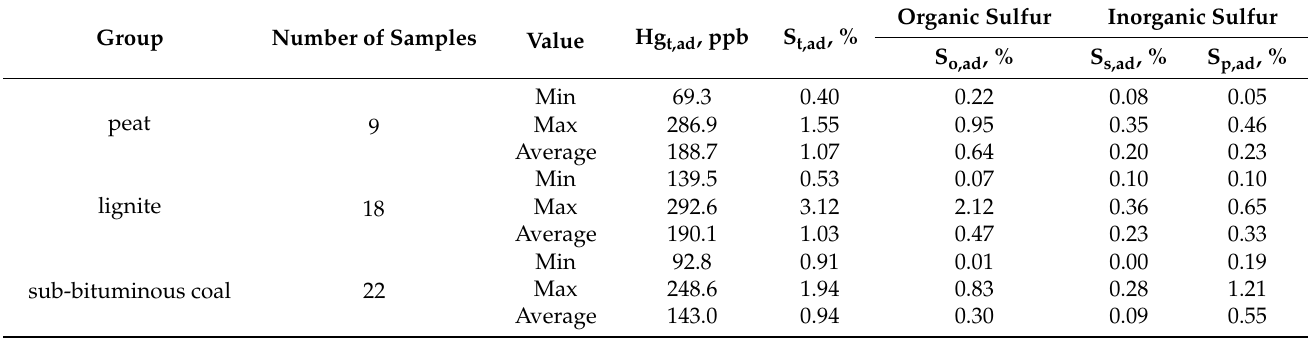
Table 4. Contents of Hg, sulfur, organic sulfur and inorganic sulfur in coal